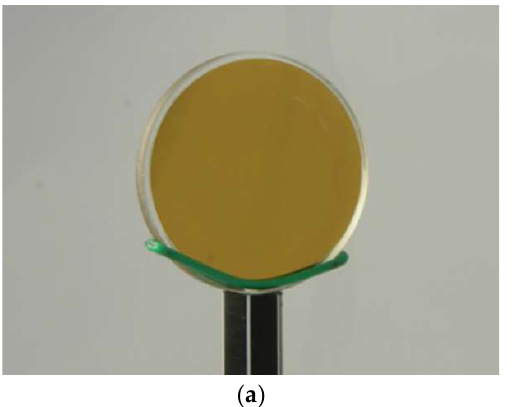
Figure 4. The general view of the round optic filter with a diameter of 30 mm with interference Si– SiO coating at a different lighting: ( a )—illumination for reflection; and ( b )—enlightenment.